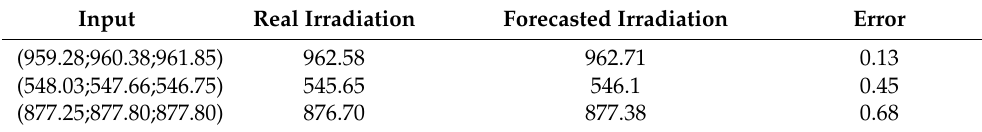
Table 2. Irradiation forecast testing.